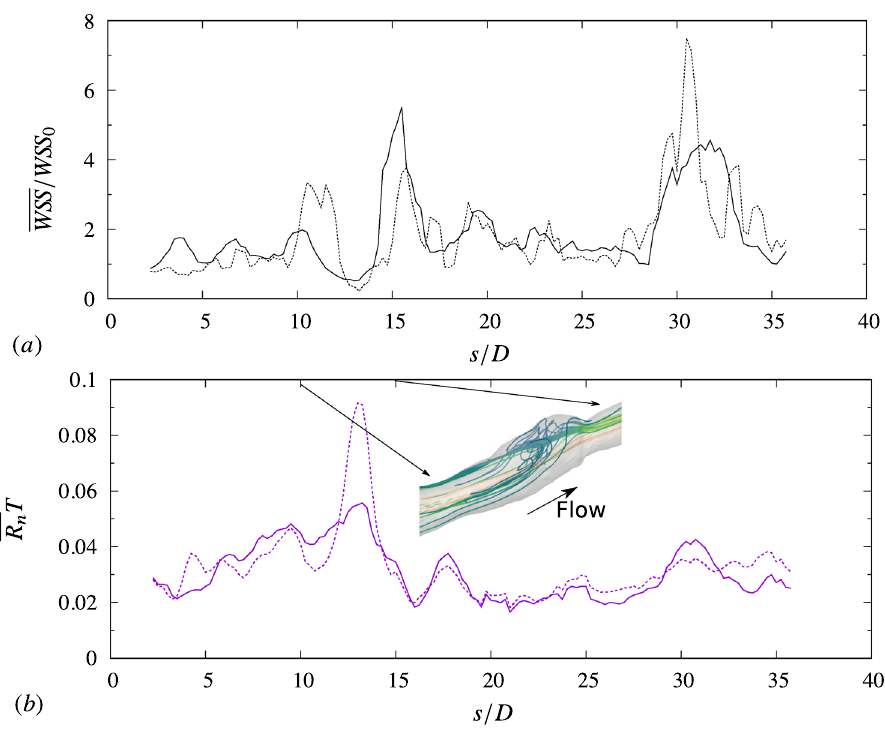
Figure 6. Comparison between simulation results using the arterial geometry from the baseline exam and the six-month follow-up exam: ( a ) WSS distribution, normalized by the reference value WSS 0 ; ( b ) rate of adhesion for neutrophils. Solid lines, baseline geometry; dashed lines, follow-up geometry. The inset in ( b ) shows particle lines for the blood flow in the follow-up